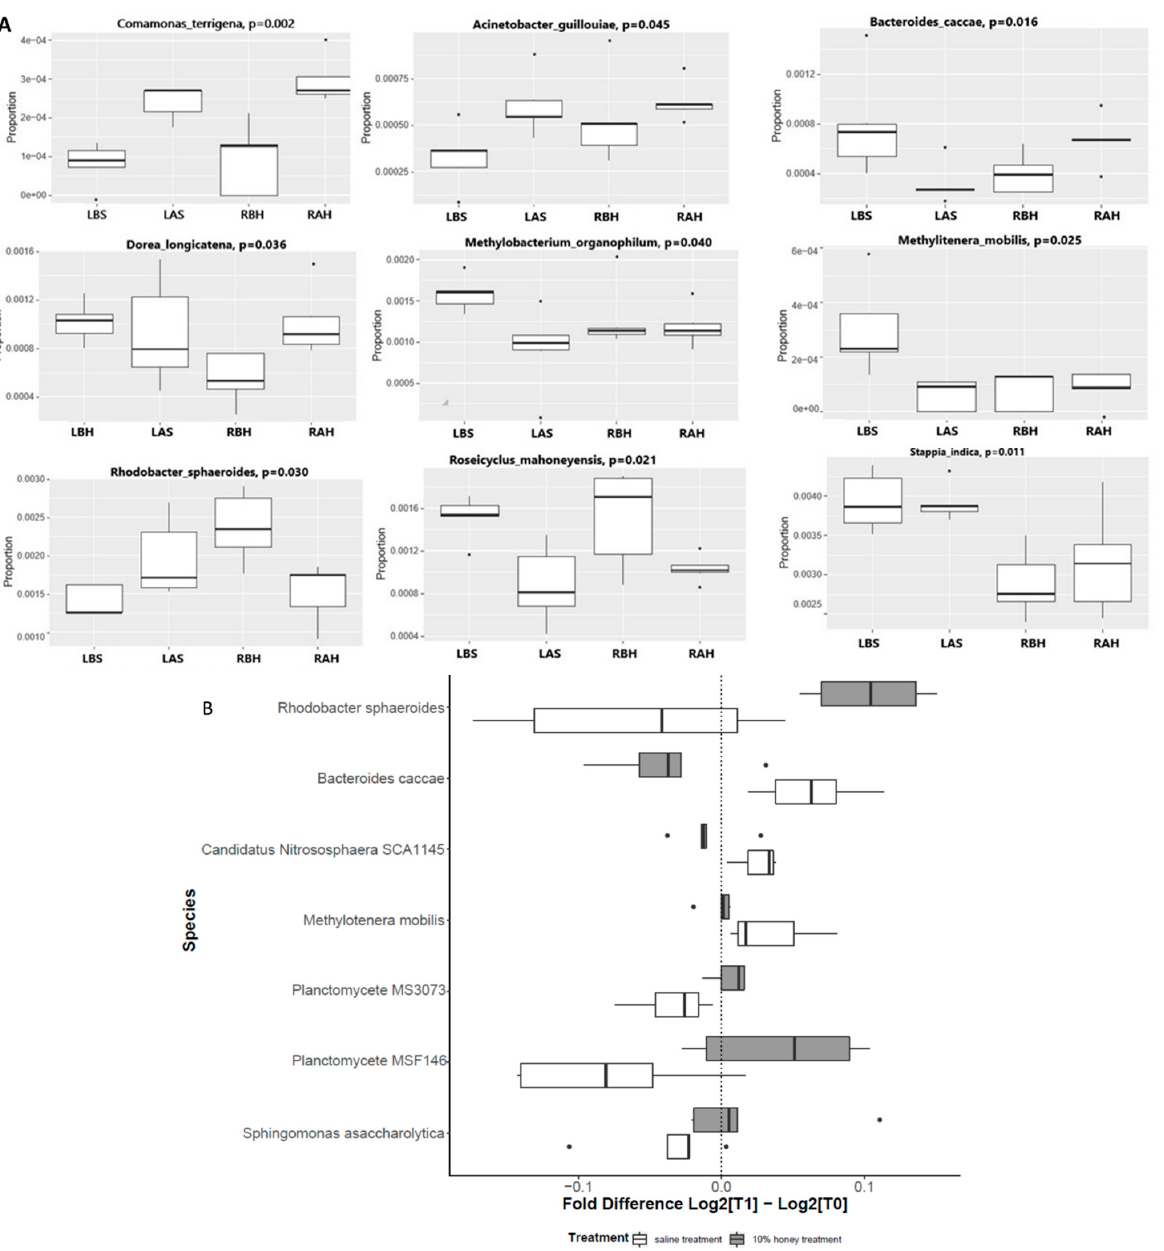
Figure 6. Alteration in nasal microbiome. ( A ) Species-level (excluding species present in <10% of the sample) showing differential abundance between study groups with high significance using the Kruskal–Wallis test; ( B ) Species-level distinction with honey treatment in AtR patients. The fold differences in species before and after honey ( right ) and saline ( left ) treatment.